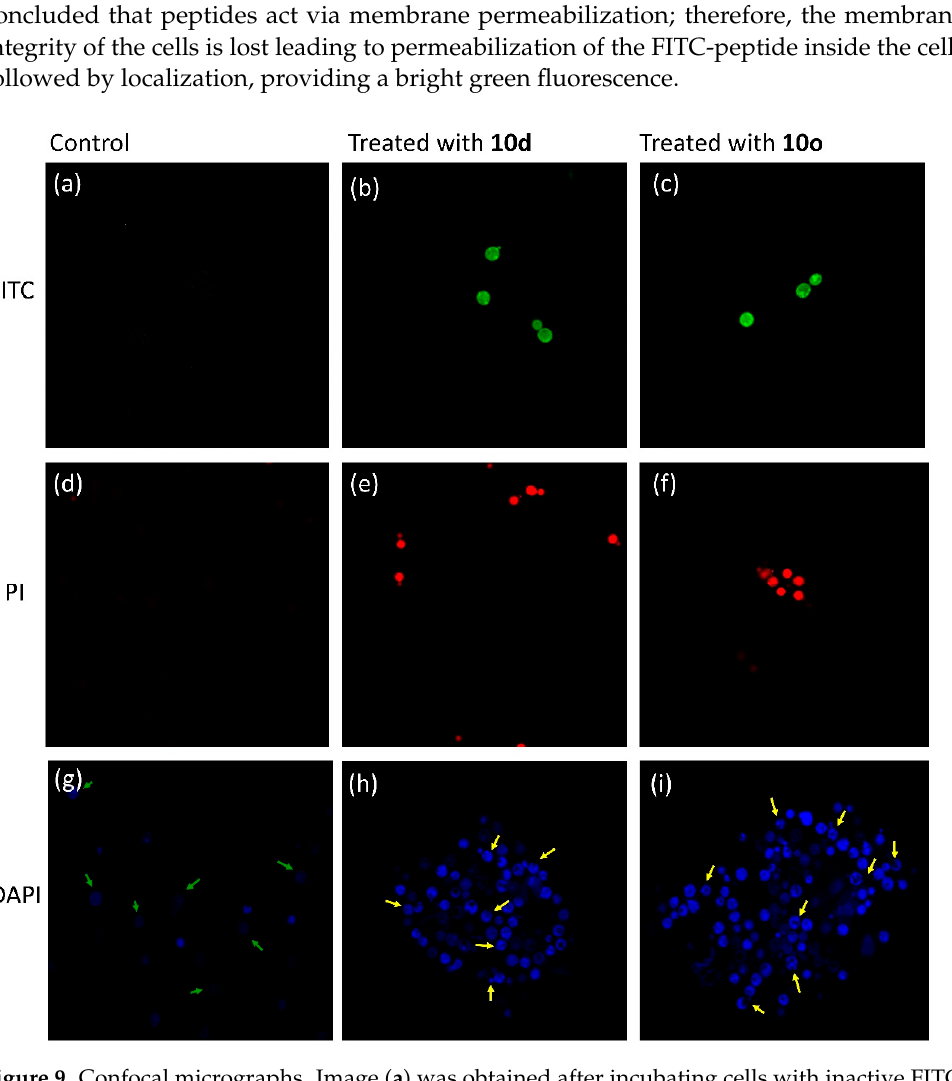
Figure 9. Confocal micrographs. Image ( a ) was obtained after incubating cells with inactive FITC-labeled peptide 10h , while image ( b ) was obtained after treatment with active peptide 10d tagged with FITC and image ( c ) was obtained after treatment with active peptide 10o tagged with FITC. PI uptake assay: image ( d ) was obtained after incubating cells with PI, while image ( e ) was obtained after treatment with active peptide 10d and image ( f ) was obtained after treatment with active peptide 10o . DAPI uptake assay: image ( g ) was obtained after incubating cells with DAPI, while image ( h ) was obtained after incubating cells treated with 10d with DAPI and image ( i ) was obtained after incubating cells treated with 10o with DAPI.